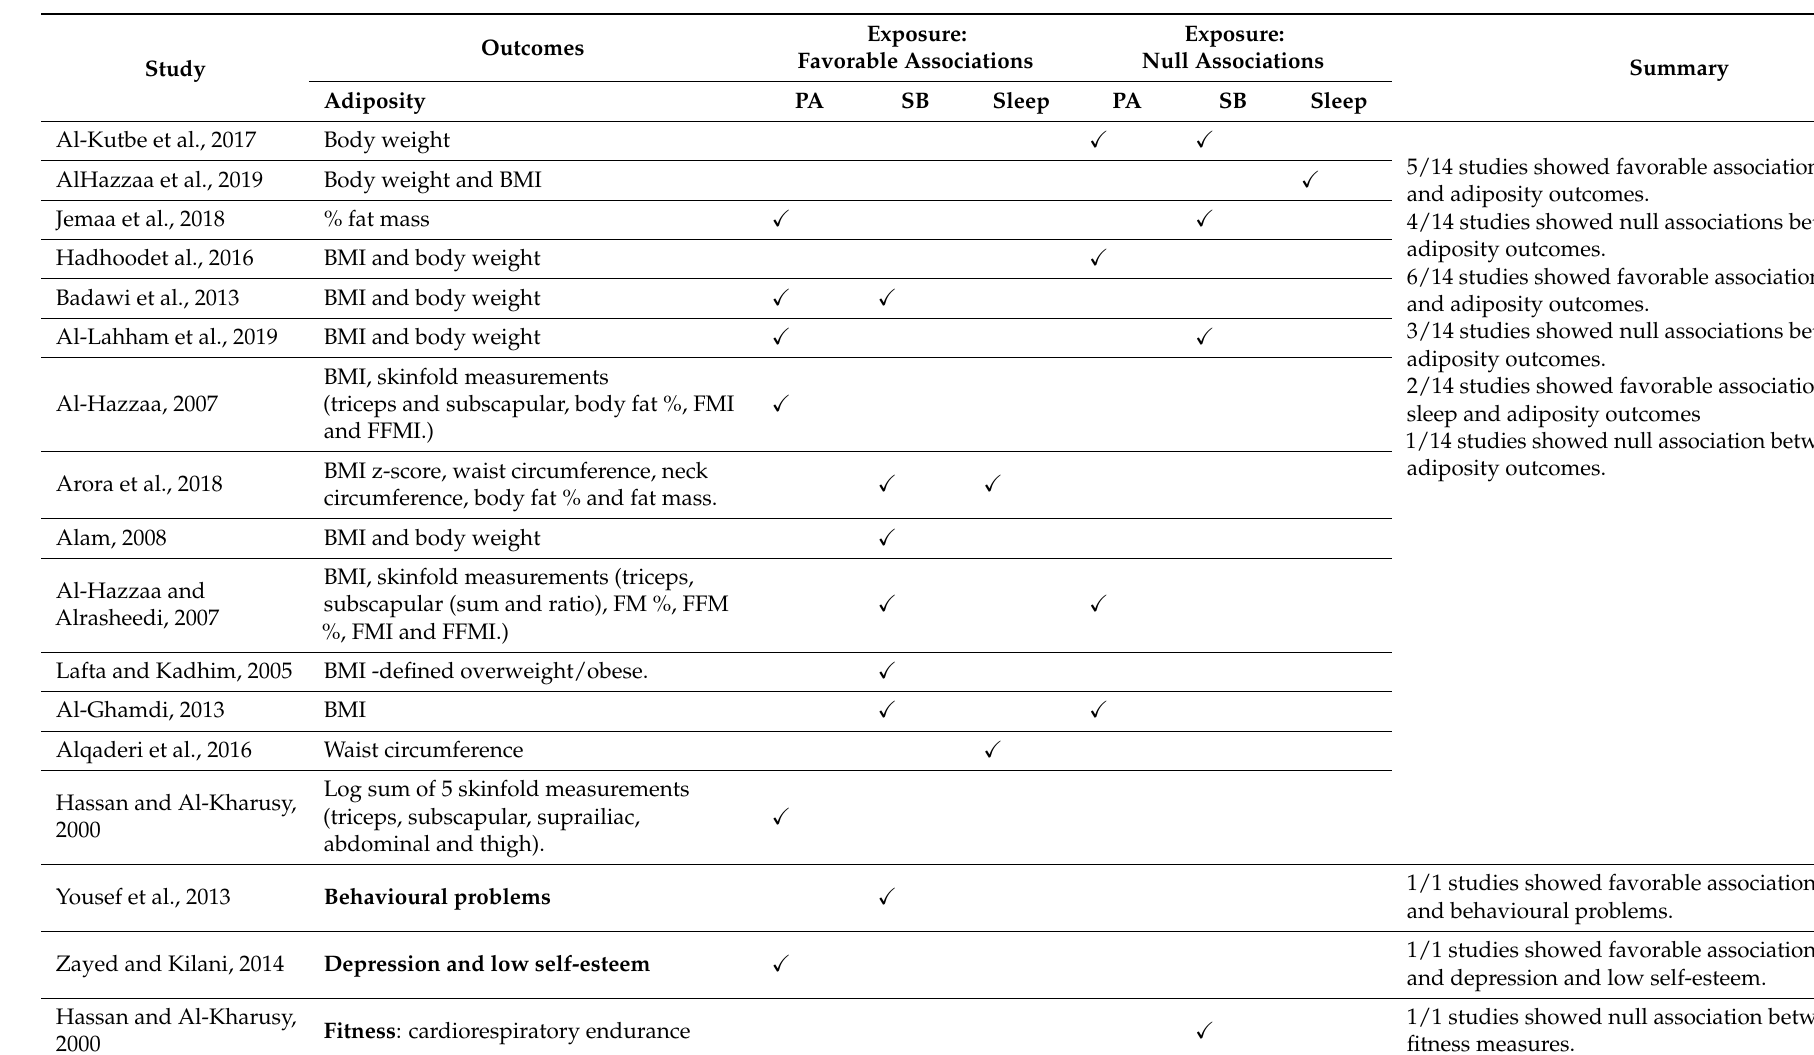
Table 3. Results of